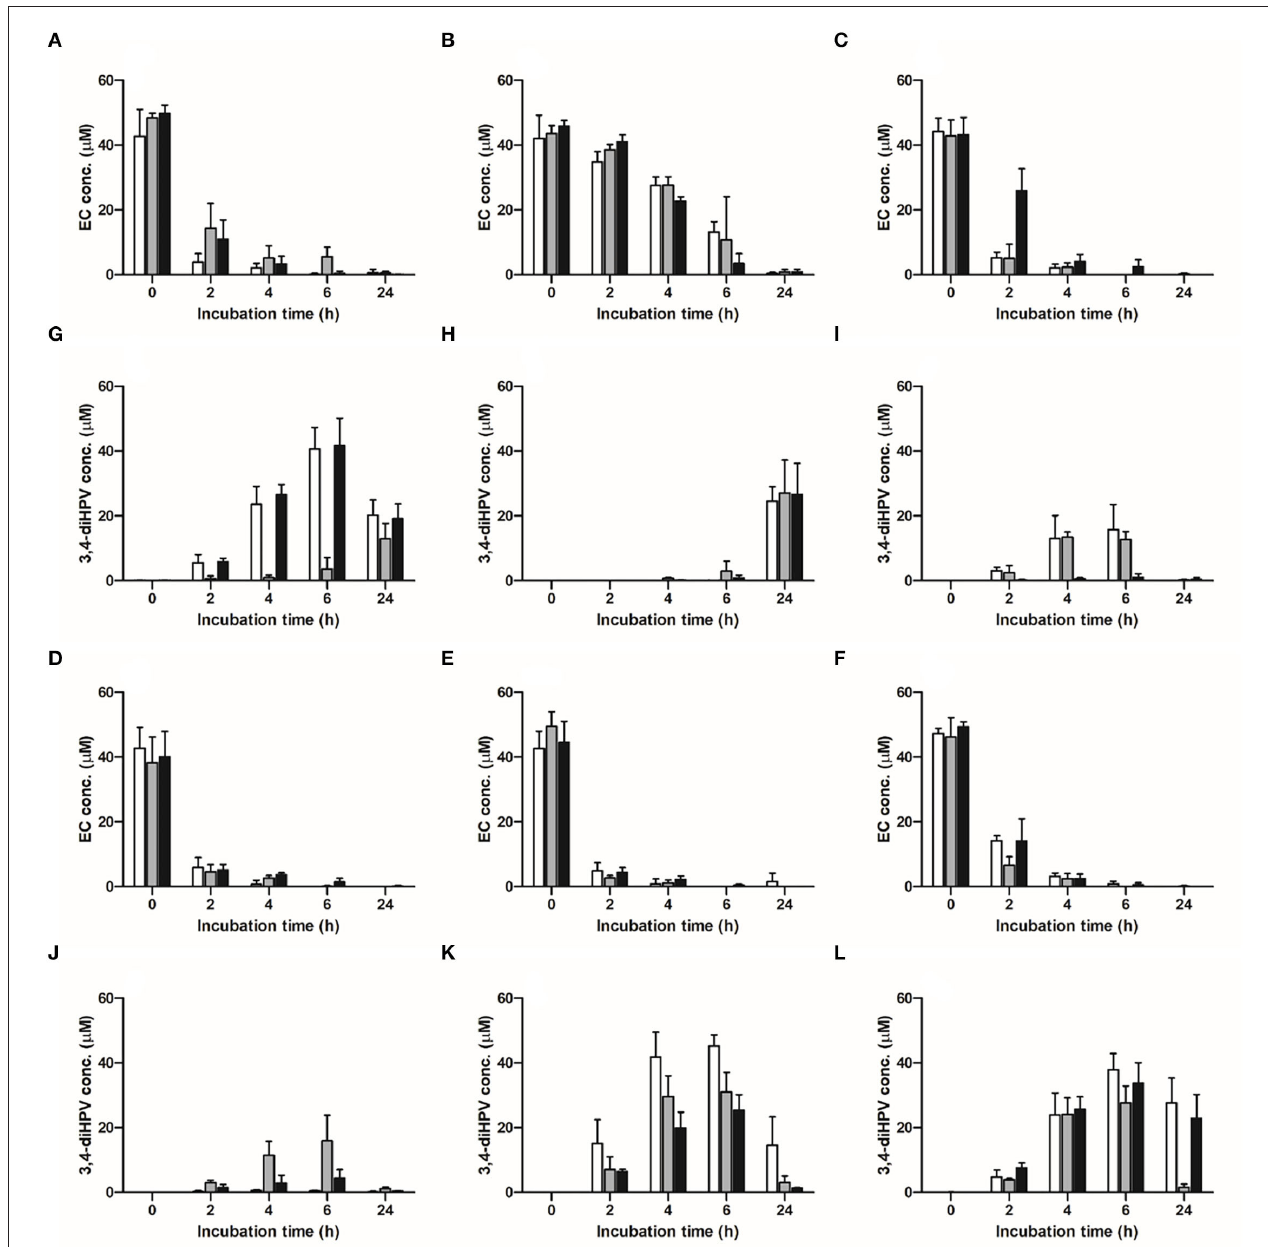
FIGURE 2 | Time-dependent microbial depletion of EC and formation of 3,4-diHPV in anaerobic incubations with fecal samples from six individuals obtained in three collecting weeks. (A–F) EC depletion in individuals 1–6; (G–L) 3,4-diHPV formation in individuals 1–6. White column: collection 1; gray column: collection 2; black column: collection